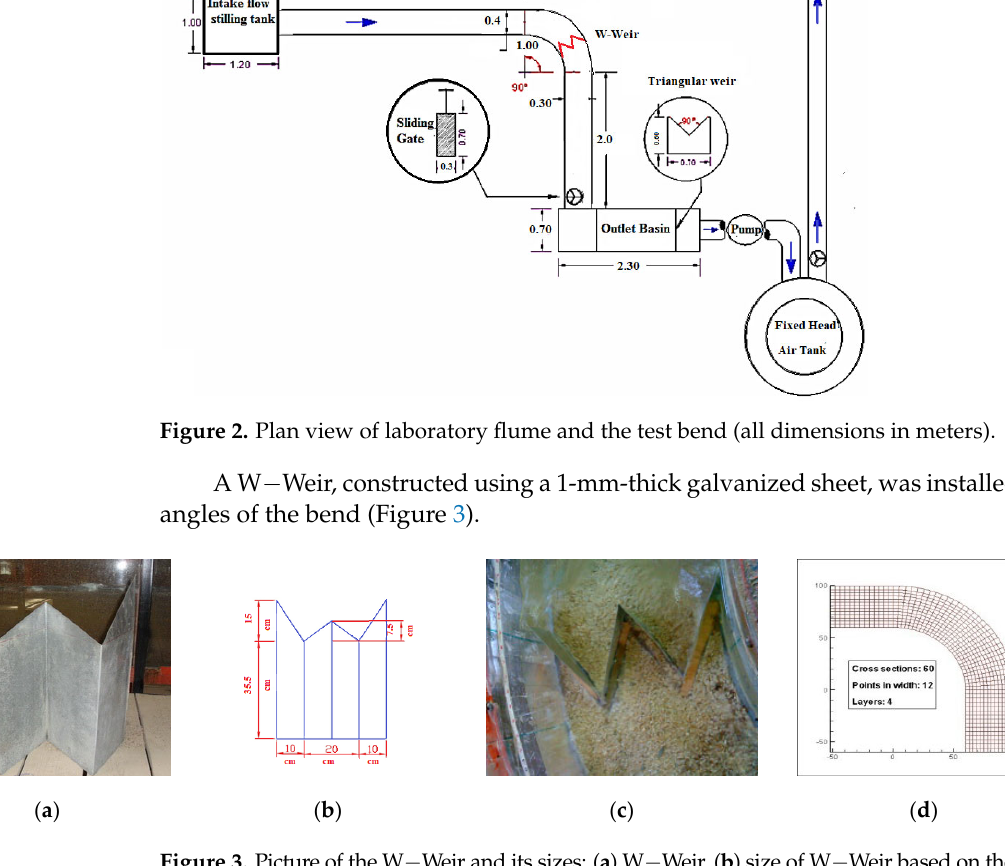
Figure 3. Picture of the W − Weir and its sizes: ( a ) W − Weir, ( b ) size of W − Weir based on the Bhuiyan et al. study [18], ( c ) W − Weir installed in the flume, and ( d ) plan view of the mesh for measurement nodes.